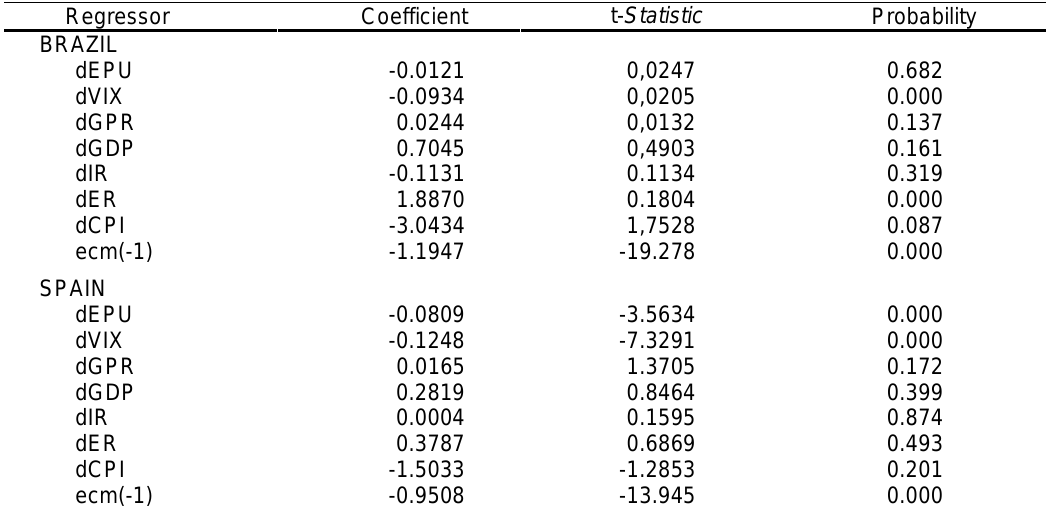
Table 6. Short-term ARDL model coefficients